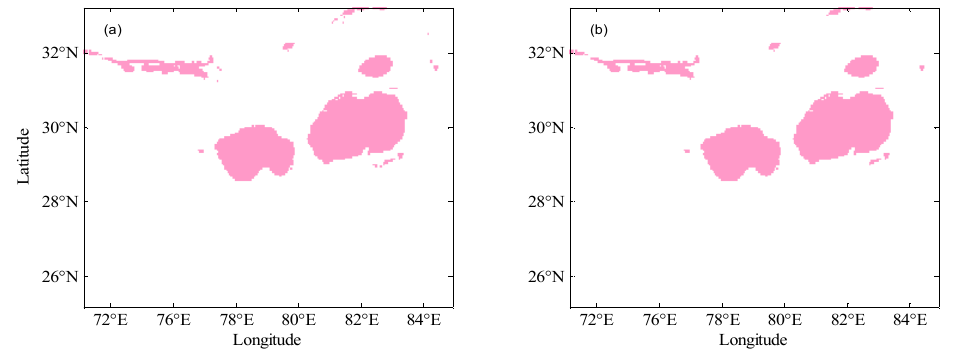
Figure 4. Integrated detection result of convective cloud: ( a ) Before the removal of “broken cloud”; ( b ) After the removal of “broken cloud”.